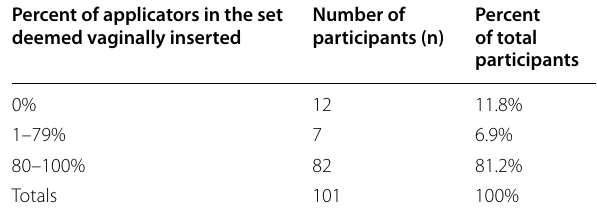
Table 2 Determination of vaginal insertion of applicators